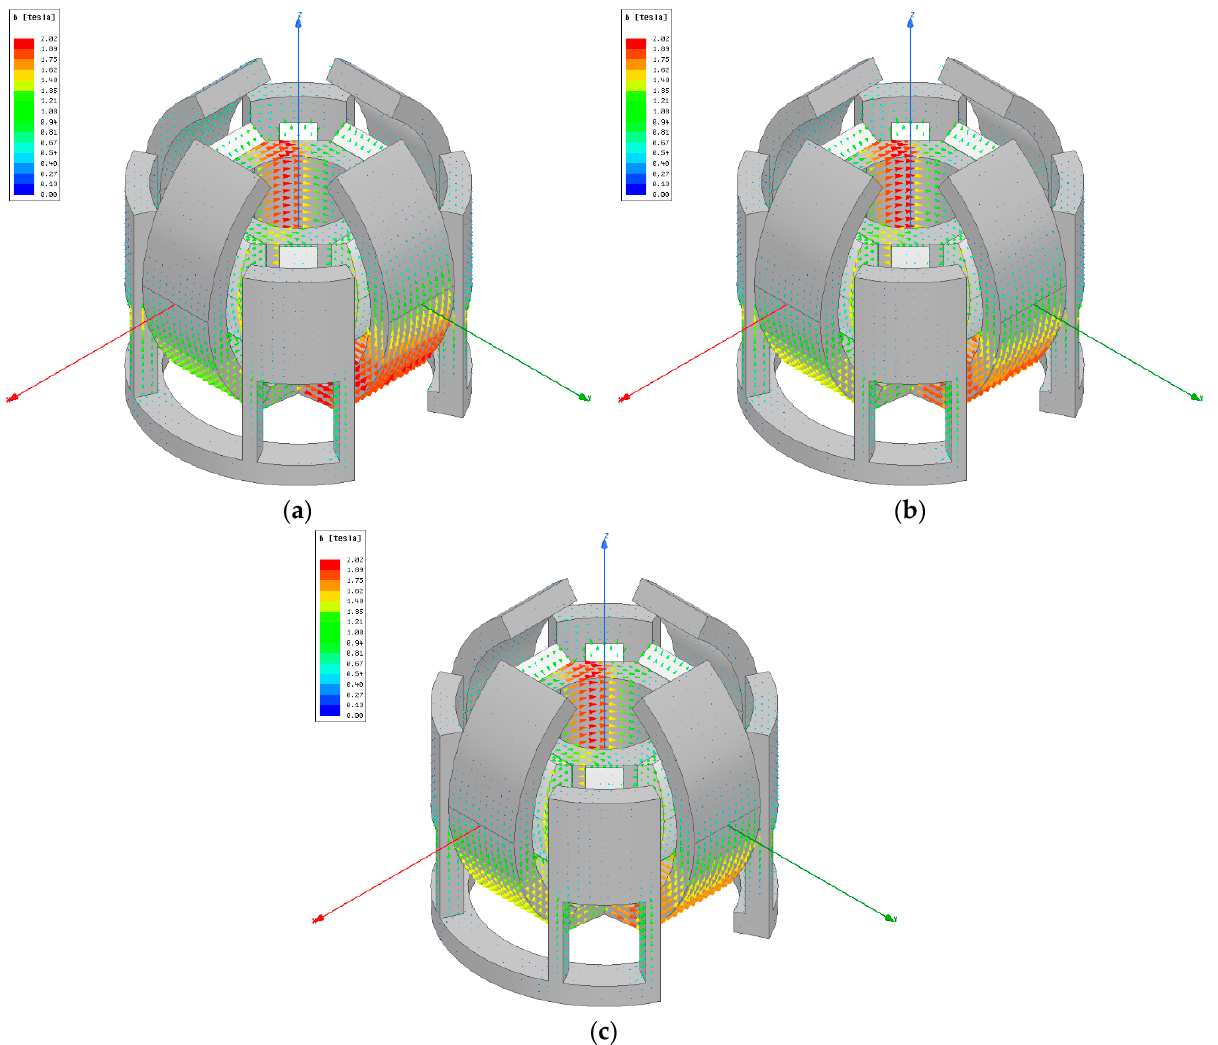
Figure 10. The vector diagram of the magnetic flux density distribution in the yoke and magnet when the coils of ( a ) original and ( b ) proposed 3-DOF spherical motor are powered on and ( c ) those are not powered on, respectively.